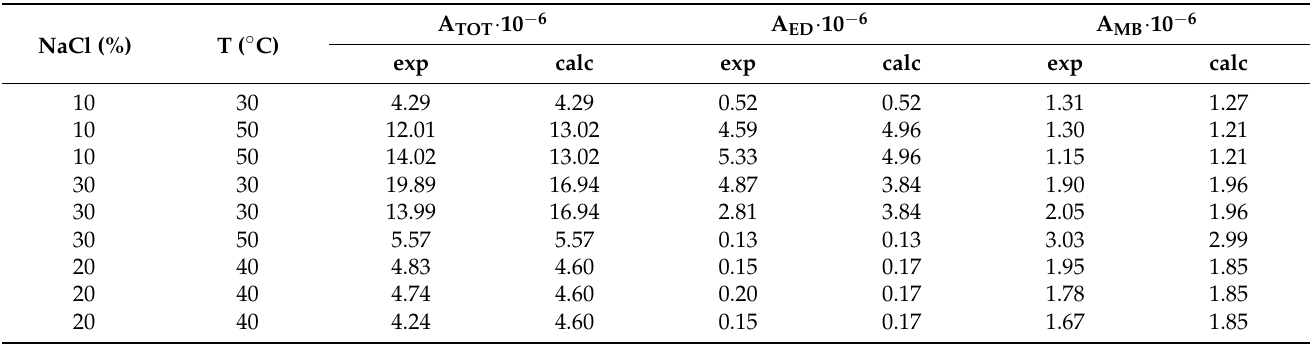
Table 4. Points of the DoE adopted to investigate SPME efficiency of the DVB/CAR/PDMS fiber with experimental values of the responses: total area of the GC chromatogram (A TOT ), peak areas of ethyl decanoate (A ED ), and 3-methyl-1-butanol (A MB